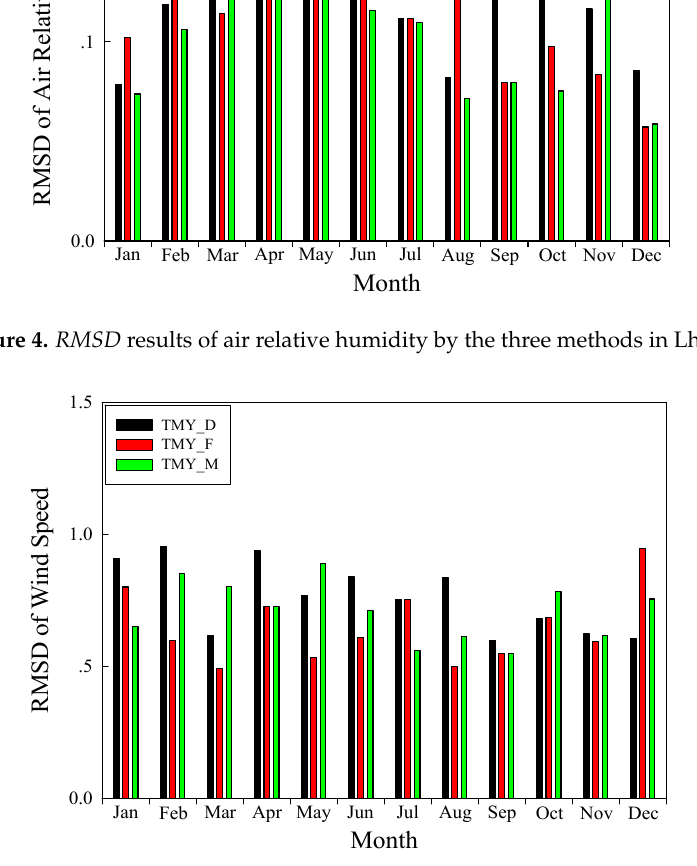
Figure 5. RMSD results of wind speed by the three methods in Lhasa.